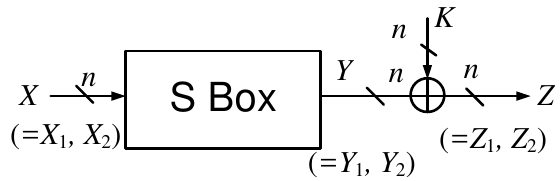
Figure 12: Cipher model used in